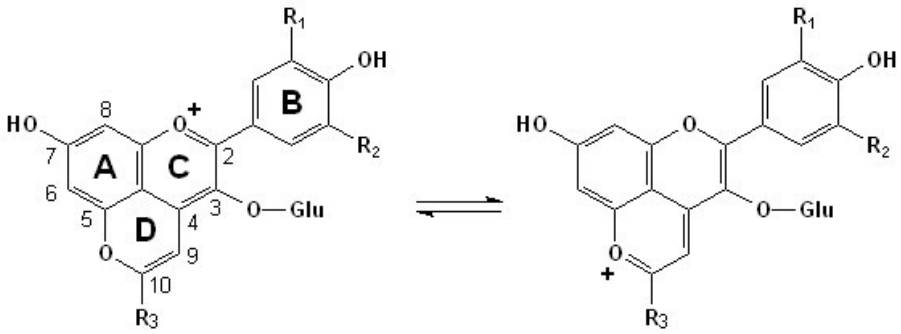
Figure 1. General structures of pyranoanthocyanins derived from anthocyanidin-3- O - glucoside in red wines and the dynamic equilibrium between their different flavylium cation forms. The R and R groups could be H, OH, OCH 1 2 COOH, CH , (vinyl)phenols, (vinyl)flavanols 3